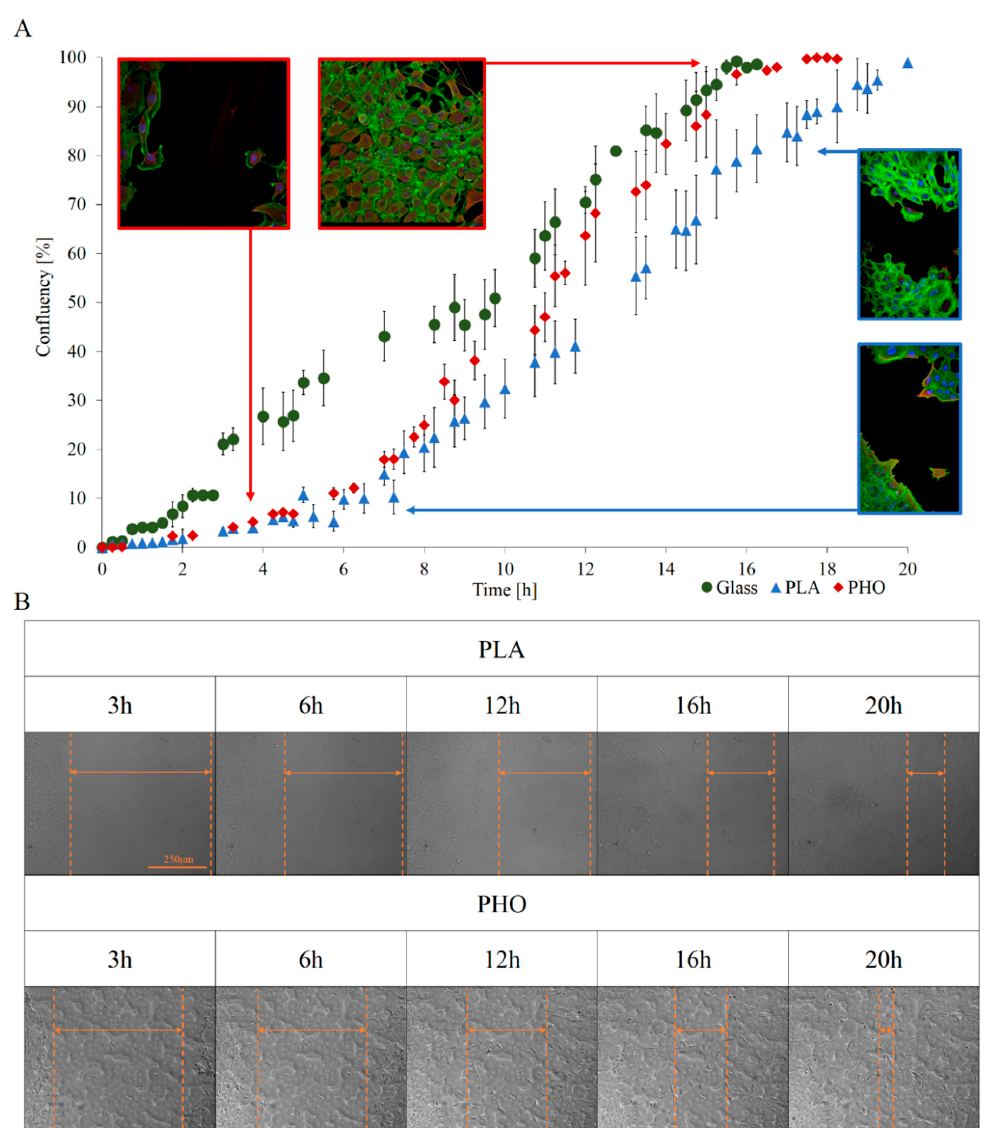
Figure 3. Wound healing assay results. Quantitative analysis allowed to show and analyze the dynamics of wound healing ( A ), and thanks to the use of high-resolution microscopic imaging wound healing and migration of cell groups to its center can be observed at selected timepoints ( B ). Cells for selected timepoints were fixed and stained with solution containing rhodamine-labeled phalloidin (Sigma Aldrich) to dye the actin fibers. DAPI (Thermo Fisher Scientific) was used for nucleus